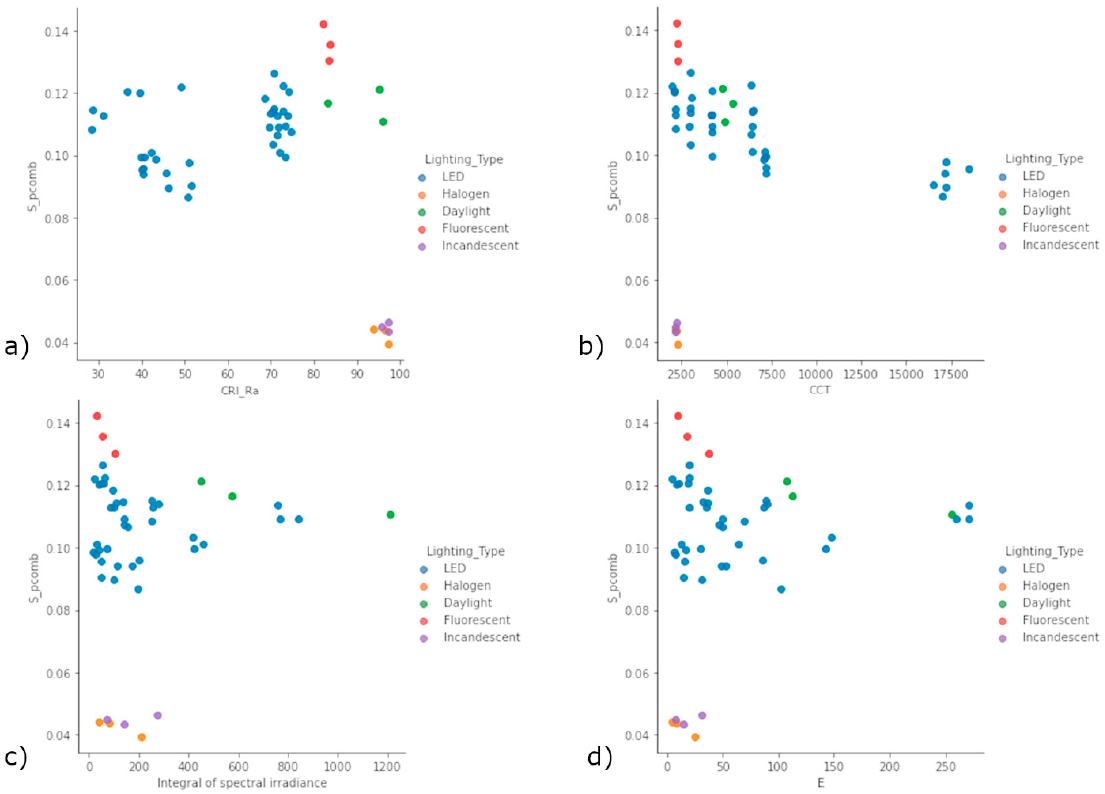
Figure 10. S_pcomb as a function of different parameters: ( a ) CRI_Ra; ( b ) CCT; ( c ) Integral of spectral irradiance; ( d ) E. CRI_Ra = Colour Rendering Index, CCT = Correlated Colour Temperature, E = luminance.